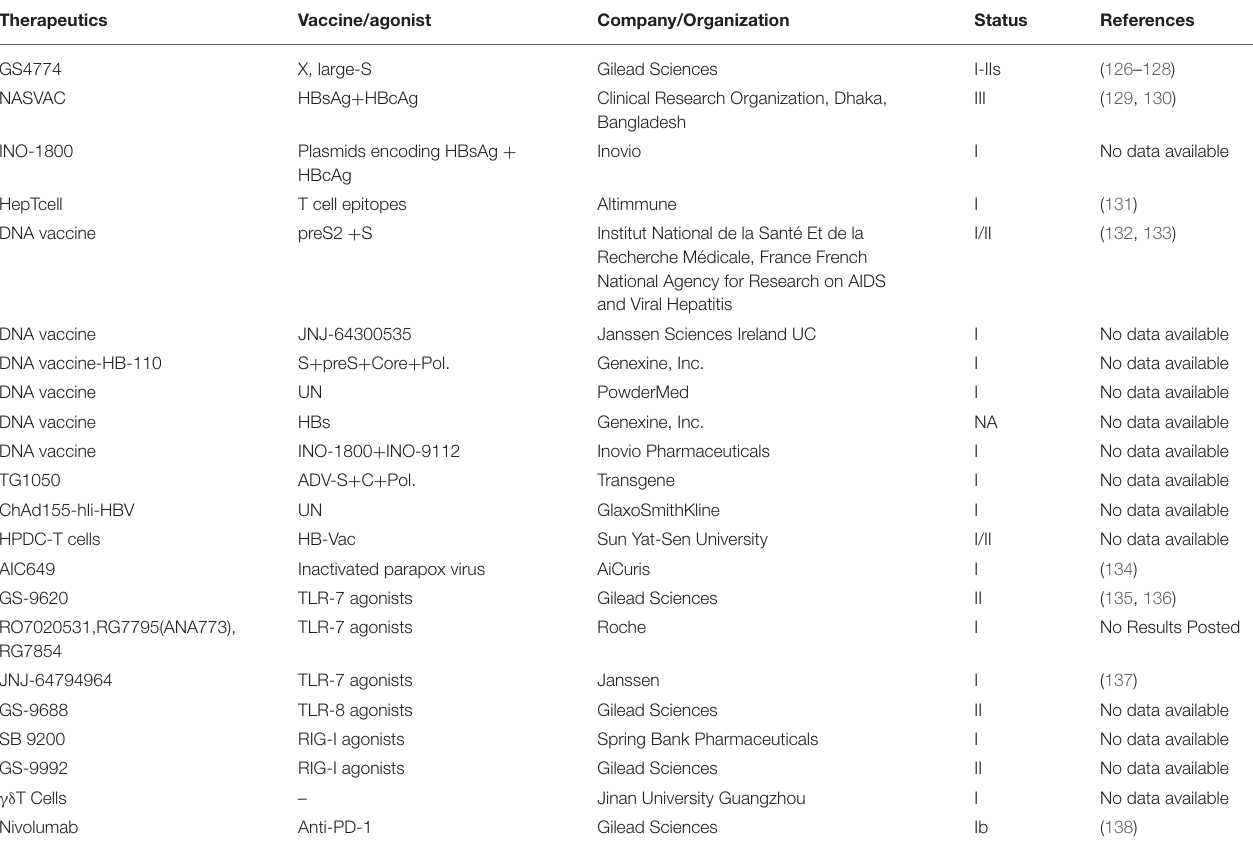
TABLE 1 | Current clinical trials based on